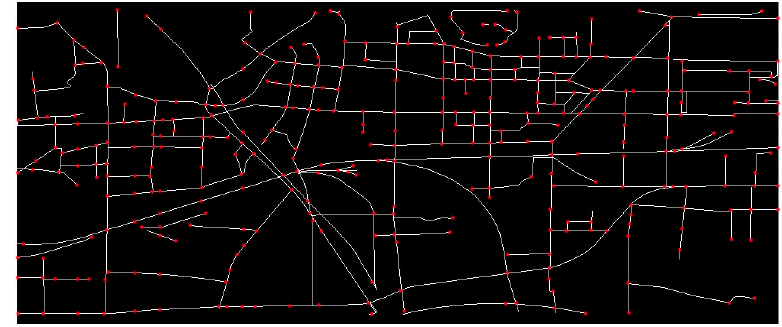
Figure 3. The distribution of roads and nodes.